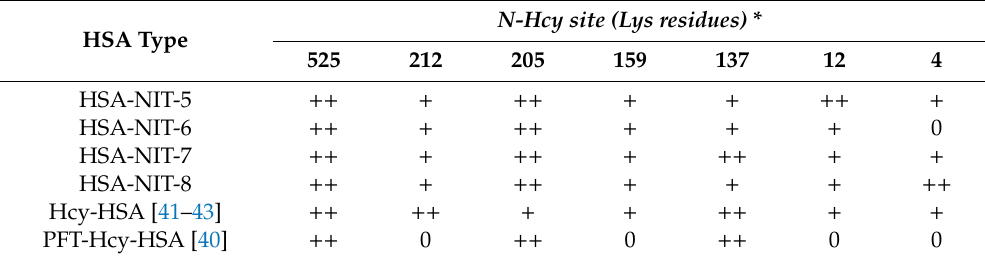
Table 2. Lysines in N -Hcy-albumin conjugates modified by